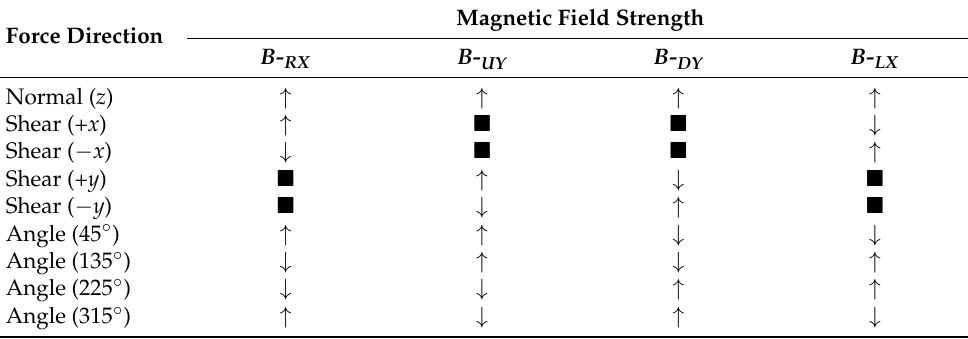
Table 1. Look-up table for the magnetic field strength against applied force. Force